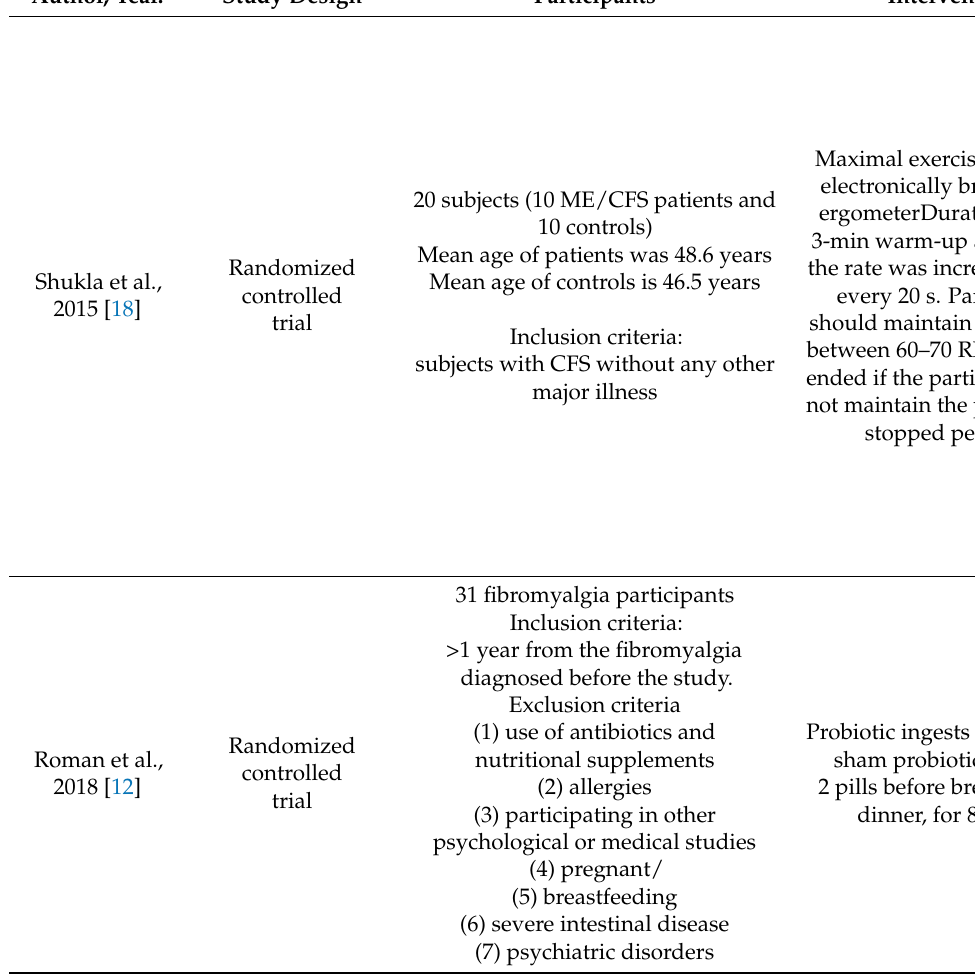
Table 1. Studies data